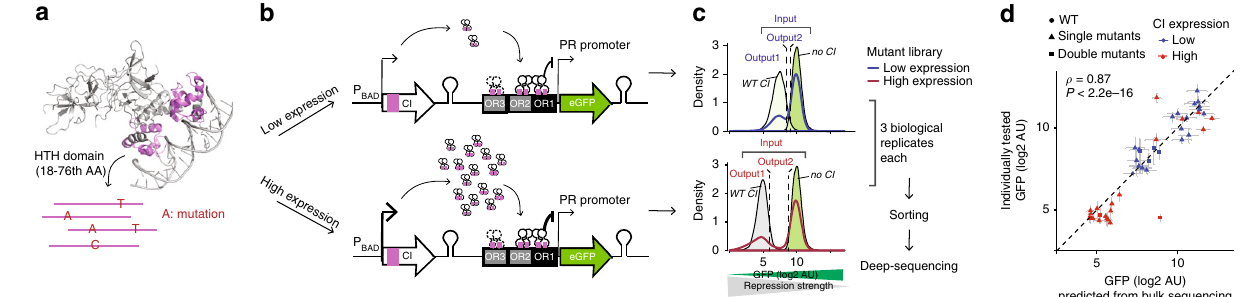
Fig. 1 Deep mutagenesis of CI DNA-binding domain at two expression levels. a CI-operator complex with mutated HTH domain in magenta. b Experimental design. c Distribution of GFP target gene expression when the mutant library is expressed at high and low levels and when WT or no CI is expressed. Sorted populations with GFP level similar to the wild-type population (Output1), and population with intermediate GFP level (Output2) were collected for deep sequencing. d Correlation of target gene expression estimated by deep sequencing with target gene expression individually quanti fi ed for wild type, 22 single and double mutants at low and high expression levels. Error bars denote standard error of the mean from four ( y -axis) and three ( x -axis) biological